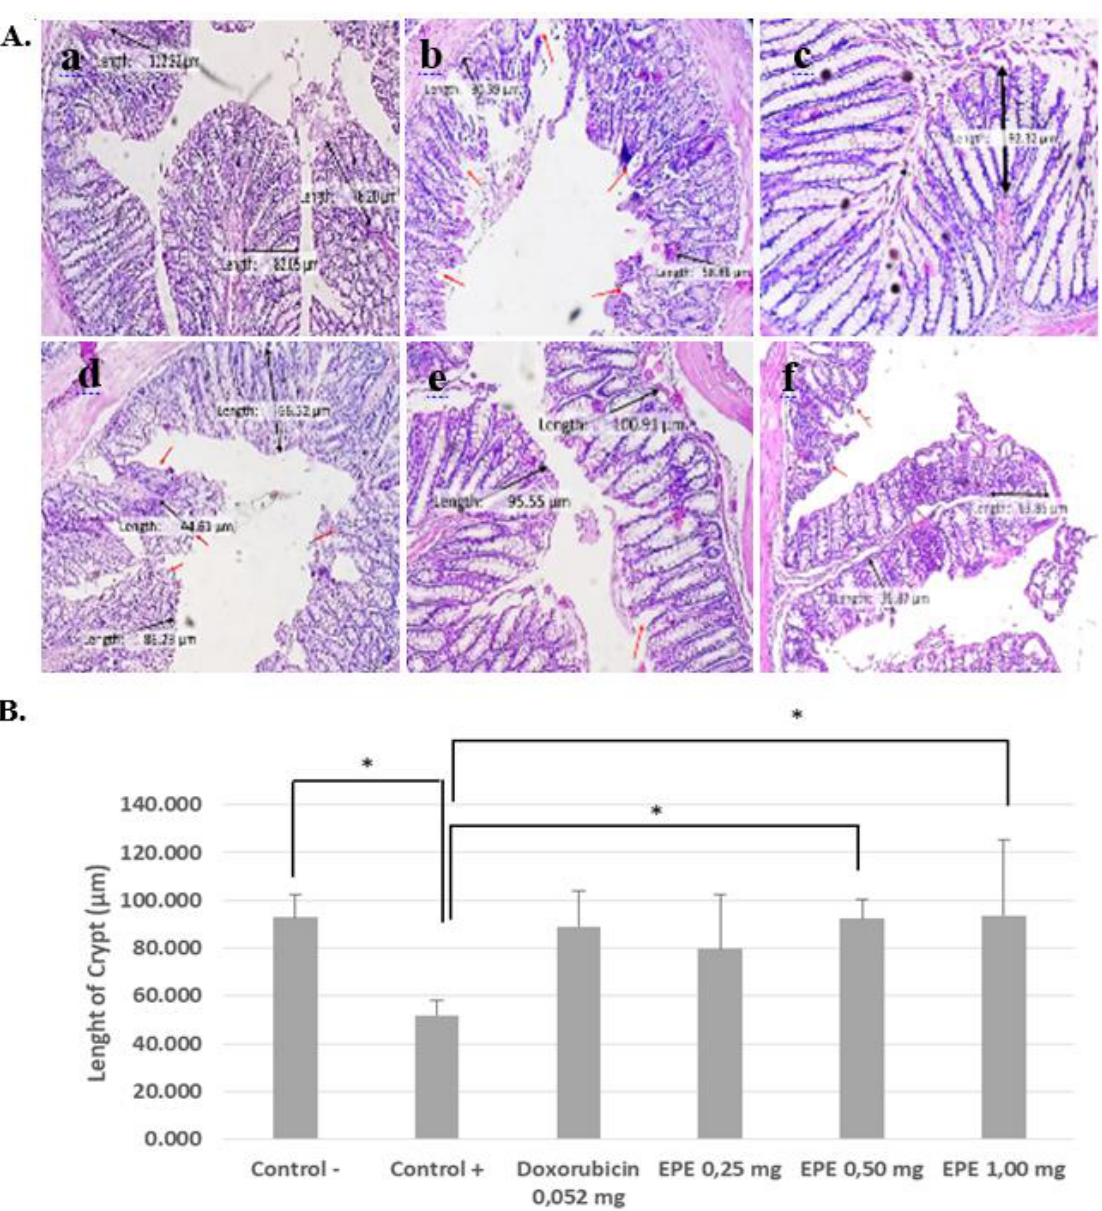
Figure 3. A. Histopathological description of colonic crypt length of the BALB/c mice of colitis-associated colon cancer model after EPE treatment . HE staining. 100x magnification. (a). C- (normal) : normal structures of colon and cryptic; (b). C+ (induction of AOM DSS) : cryptic shortening, severe epithelial damage; (c). Doxorubicin 0.052 mg/20gBW: longitudinal crypts, normal structure of colon; (d). EPE 0.25 mg/20gBW: crypt extends slightly, moderate epithelial damage; (e). EPE 0.50 mg/20gBW: prolonged crypts, mild epithelial damage; (f). EPE 1.00 mg/20gBW: prolonged crypts, mild epithelial damage. Description: ▭ = cryptic length, ↔ = epithelial damage, → = : inflammatory cell infiltration. B. Graph of crypt length of BALB/c mice of colitis-associated colon cancer model after EPE treatment. Description: *shows the level of significant difference p